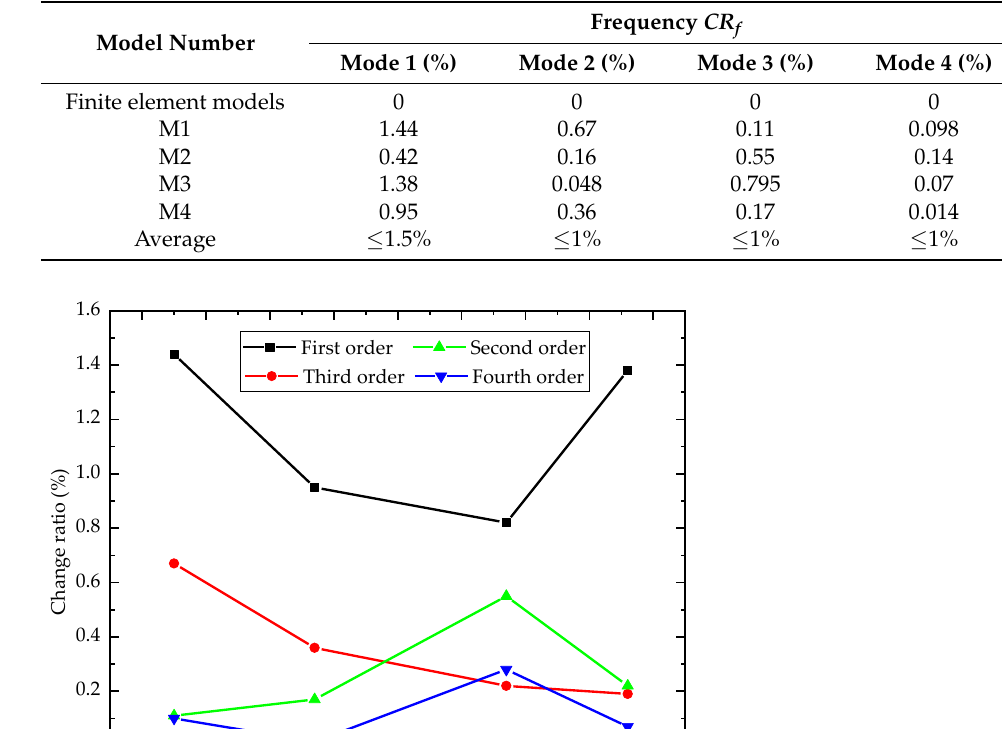
Table 6. The change rate of natural frequency between stiffened plate specimens and the simulation.